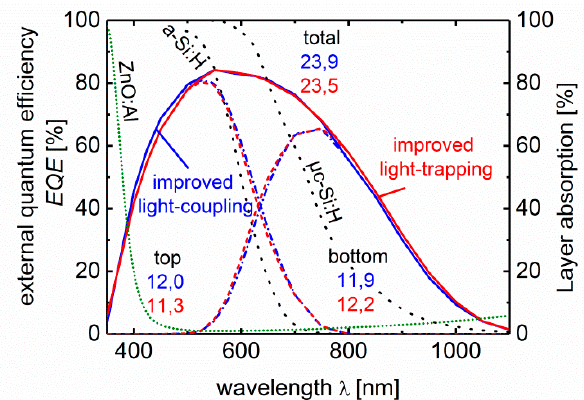
Figure 4. Cell reflection measurements of various HF (blue lines) and HCl (red lines) etched samples from series 1.